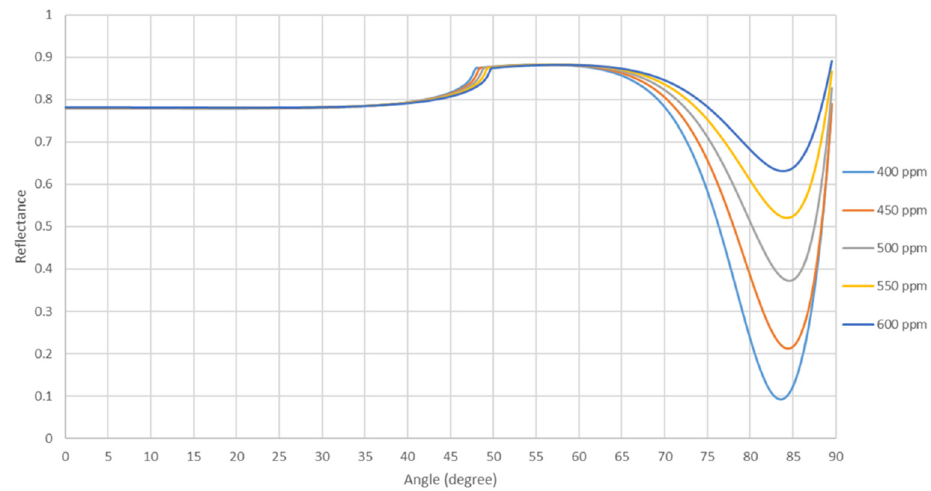
Figure 2. Reflectance curves as a function of the angle of incidence of the light in the prism and different concentration of CO 2 . The height above sea level is 1000 m. The sensor works with an incidence angle of 83.67 ◦ . The sensitivity of our sensor can be calculated from the change in reflectance per unit of change in refractive index (see Table 2 with more detail and data). Table 2. The sensitivity and resolution values of the sensor as a function of altitude and gas concentration change. Sensitivity (RIU − 1 ) Altitude (m)